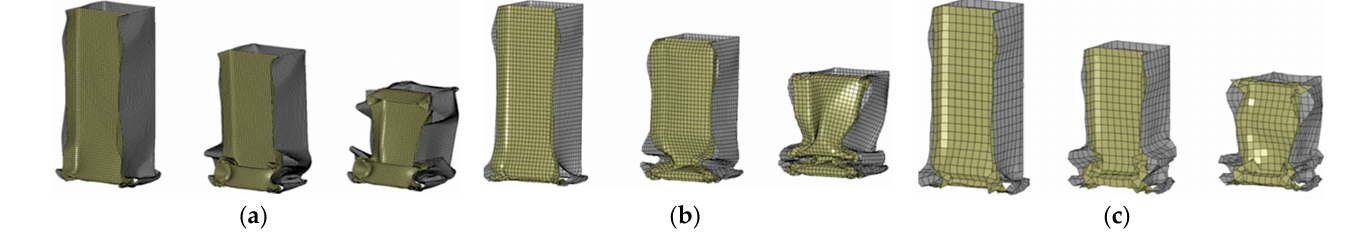
Figure 14. 30 mm, 60 mm and specimen with maximum deformations: ( a )—2 mm square finite element; ( b )—4 mm finite element; ( c )—8 mm finite element.